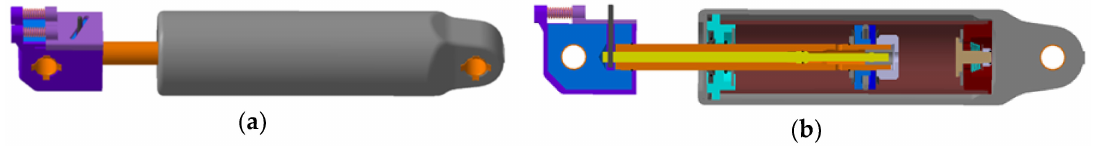
Figure 5. Final product ( a ) General view; ( b ) A constructive